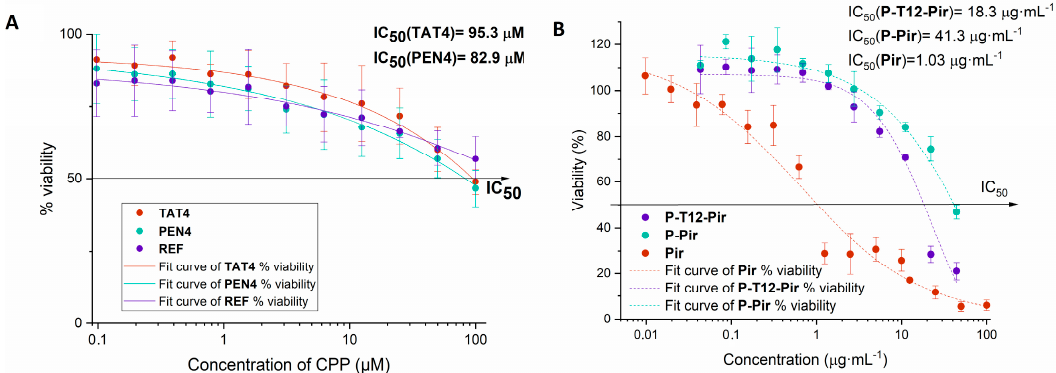
in 5% CO 2 at 37 °C. The figure corresponds to Dy-633 labeled probes TAT4 , PEN4, and REF in concentration range from 0.1 to 100 μ M CPP. Control polymer REF was used at concentration range 0.001–1 mg·mL − 1 , which corresponds to an equal amount of dye present on polymer–peptide conjugates. ( B ) The graph shows cell viability depending on concentration of pirarubicin after 24 h in 5% CO 2 at 37 °C. Figure shows pirarubicin conjugates P-T12-Pir and P-Pir in a range from 43.2 ng·mL − 1 to 44.3 μ g of pirarubicin corresponds to concentration range from 48.8 nM to 50 μ M of CPP. Free pirarubicin was used as a control in concentration range from 9.8 ng·mL − 1 to 100 μ g·mL − 1